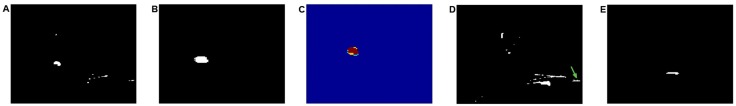
Illustration of a tubular adenoma (case IV).(A)-(E) Segmented tumours using FCMs and the proposed hybrid classification, overlapping images, and depiction of noisy voxels from imaged fatty tissue, using both classification methods. The green arrow seen in (D) indicates one of the very small regions of noise that is related to the noise region shown magnified in (E).